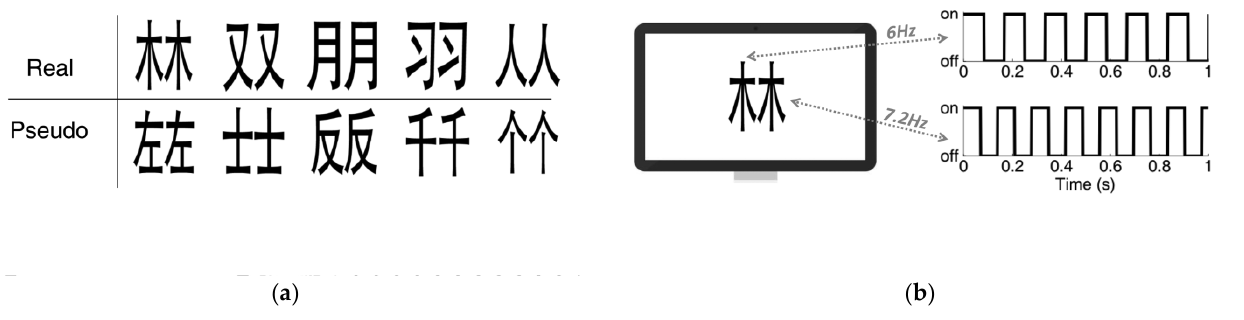
Figure 4. Stimuli . ( a ) The real (upper row) and pseudo (lower row) Chinese characters used in the experiment. ( b ) During the experiment, each side of the character was on – off flickering at 6 Hz or 7.2 Hz (balanced across trials). 7.2 Hz (balanced across